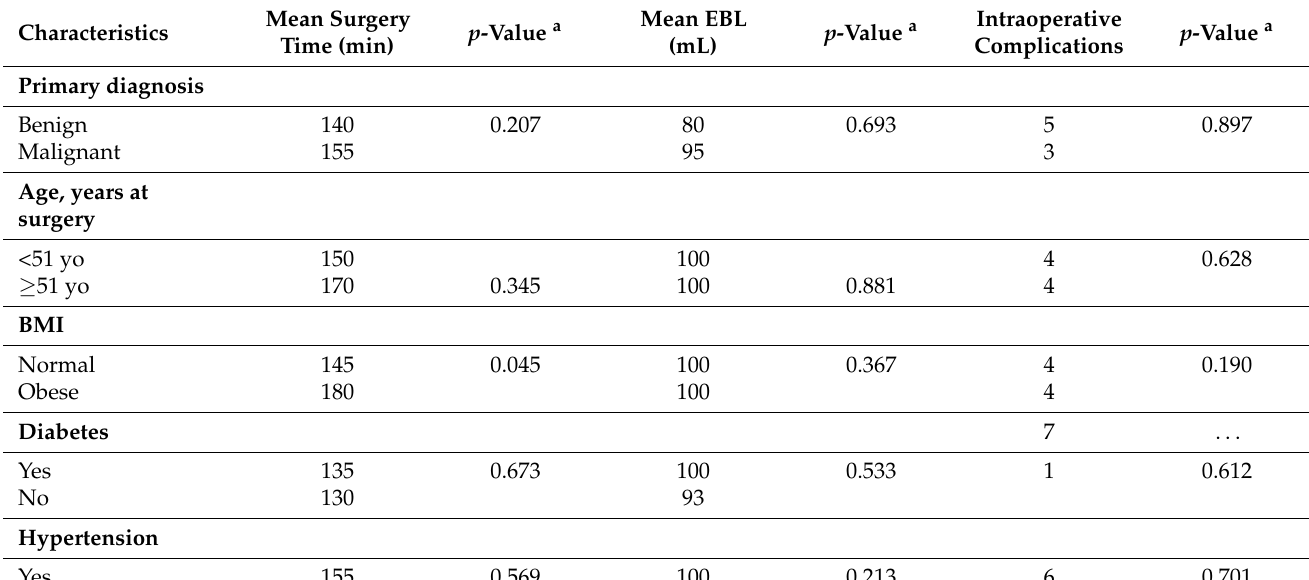
Table 3. Univariate analysis of intraoperative parameters and complications based on clinical- pathological